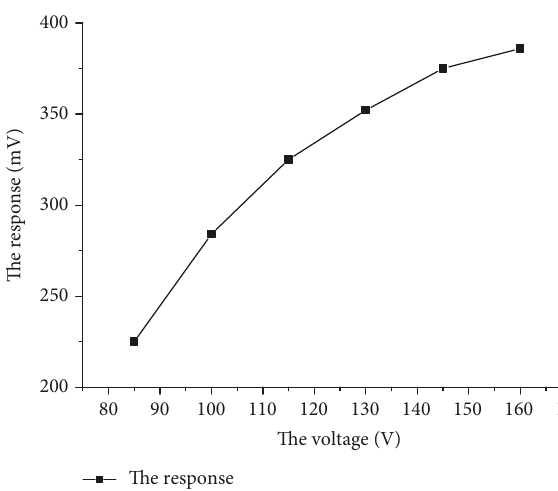
Figure 8: The e ff ect of o ff set voltage on sensor response of the PID.